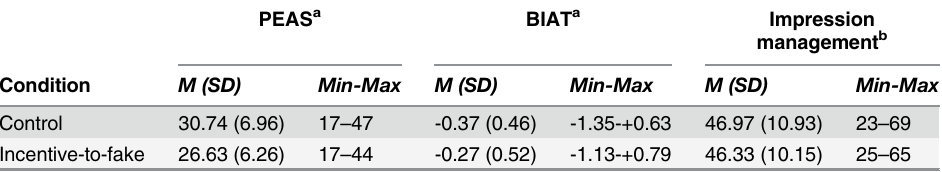
Table 1. Descriptive statistics for attitudes and strategic responding in